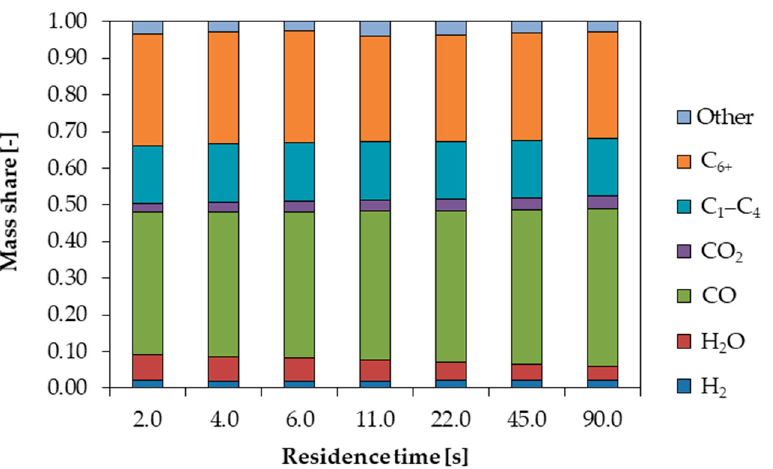
Figure 9. Distribution of the ASR 1 pyrolytic gas fractions as a function of the residence time; process temperature at 800 °C.